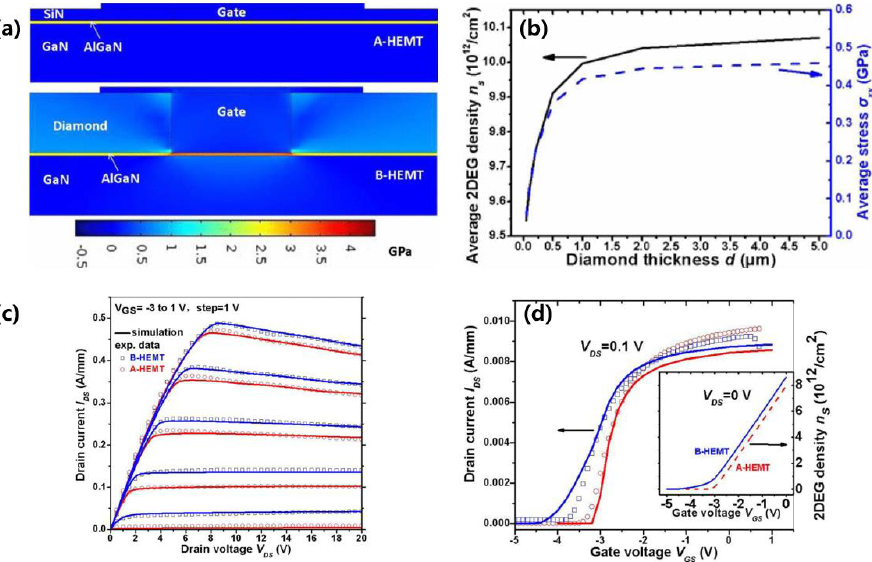
Figure 12. Simulation results of diamond capping layers on AlGaN/GaN HEMTs [123]. ( a ) 2-D distribution of stress in the A-(100 nm-thick SiN passivation layer) and B-(10 nm-thick SiN layer and 500 nm-thick NCD cap) HEMT. ( b ) Average 2-DEG density (left axis) and additional stress (right axis) in the channel under the gate for B-HEMT with varied thickness of the diamond layer. Comparison of experimental and simulation results for I DS as a function of ( c ) V DS and ( d ) V GS .